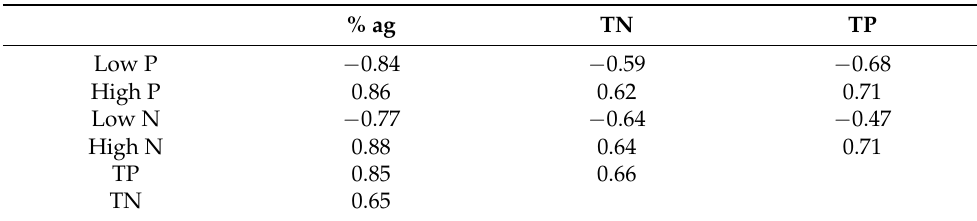
Table 3. Correlations among bacteria metrics, % watershed agriculture (% ag), total nitrogen (TN), and total phosphorus (TP). Bacteria metric correlations with % agriculture used means of all samples within each site ( n = 25), whereas TP n = 280, TN n = 281.